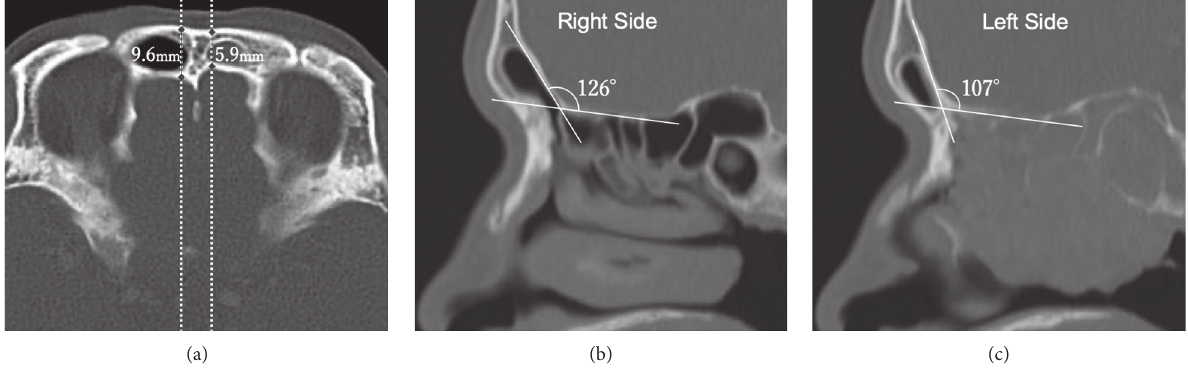
Figure 2: Computed tomography of the frontal sinus. (a) Axial section. The anteroposterior (AP) diameter of the right frontal sinus is 9.6mm and that of the left frontal sinus is 5.9 mm. (b, c) Sagittal section of the right and left frontal sinuses. The skull base-frontal sinus angle (SBA) on the right frontal sinus is 126 ° and that of the left frontal sinus is 107 °